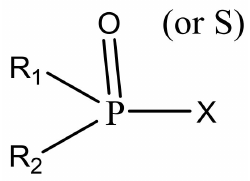
Figure 3. General structure of